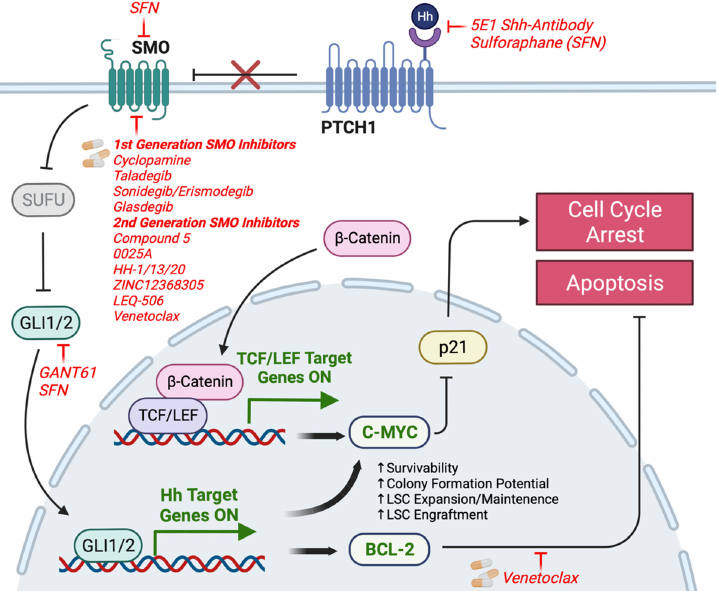
Figure 2. Hedgehog Signaling in CML. The HH signaling pathway has been implicated in CML as a BCR-ABL1-independent pathway which contributes to TKI resistance and disease progression. In a CML-specific context, GLI1/2-mediated transcription upregulates the anti-apoptotic gene BCL-2 as well as the oncogene C-MYC which promotes LSC survivability and proliferation. SMO-independent or non-canonical HH pathways, such as the Wnt/ β -Catenin pathway, also con- tribute to C-MYC upregulation. To overcome SMO-inhibitor resistance, various strategies have been investigated, such as the use of next-generation SMO inhibitors, anti-SHH antibodies, and GLI inhibitors.